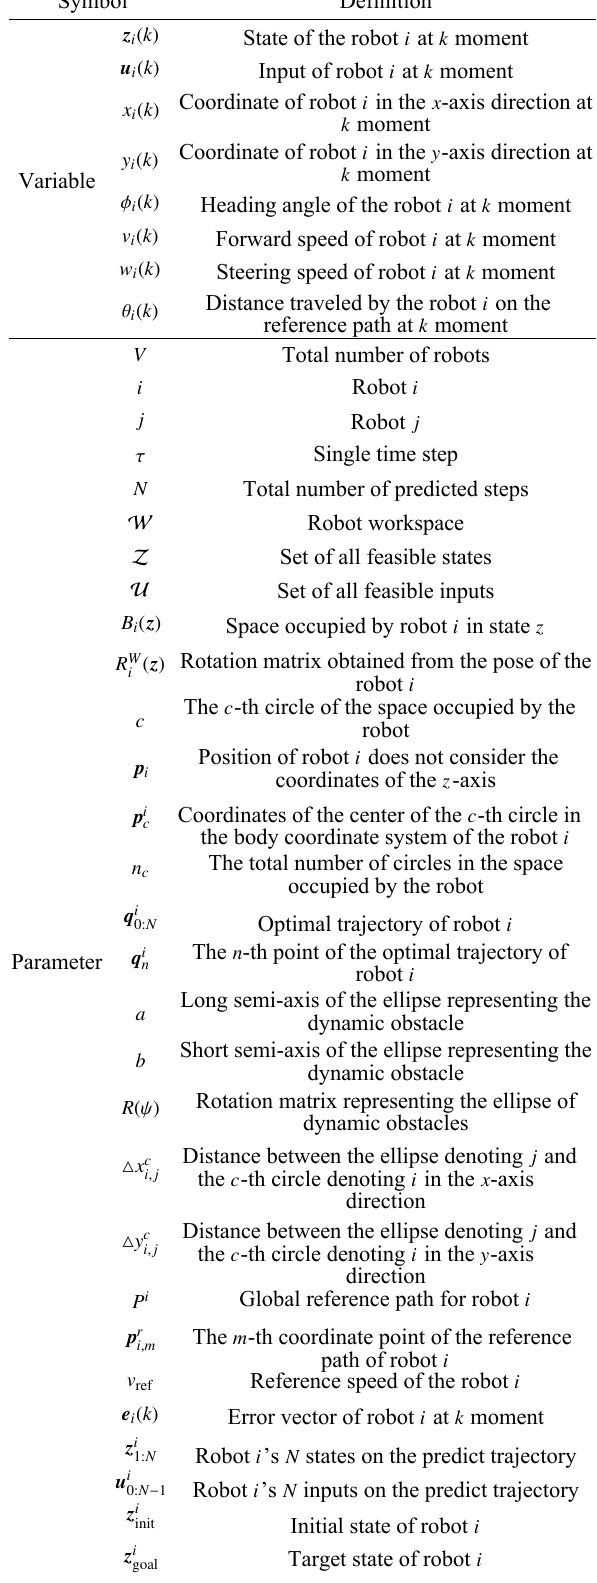
Table 1 List of variables and parameters for model predictive contouring control.